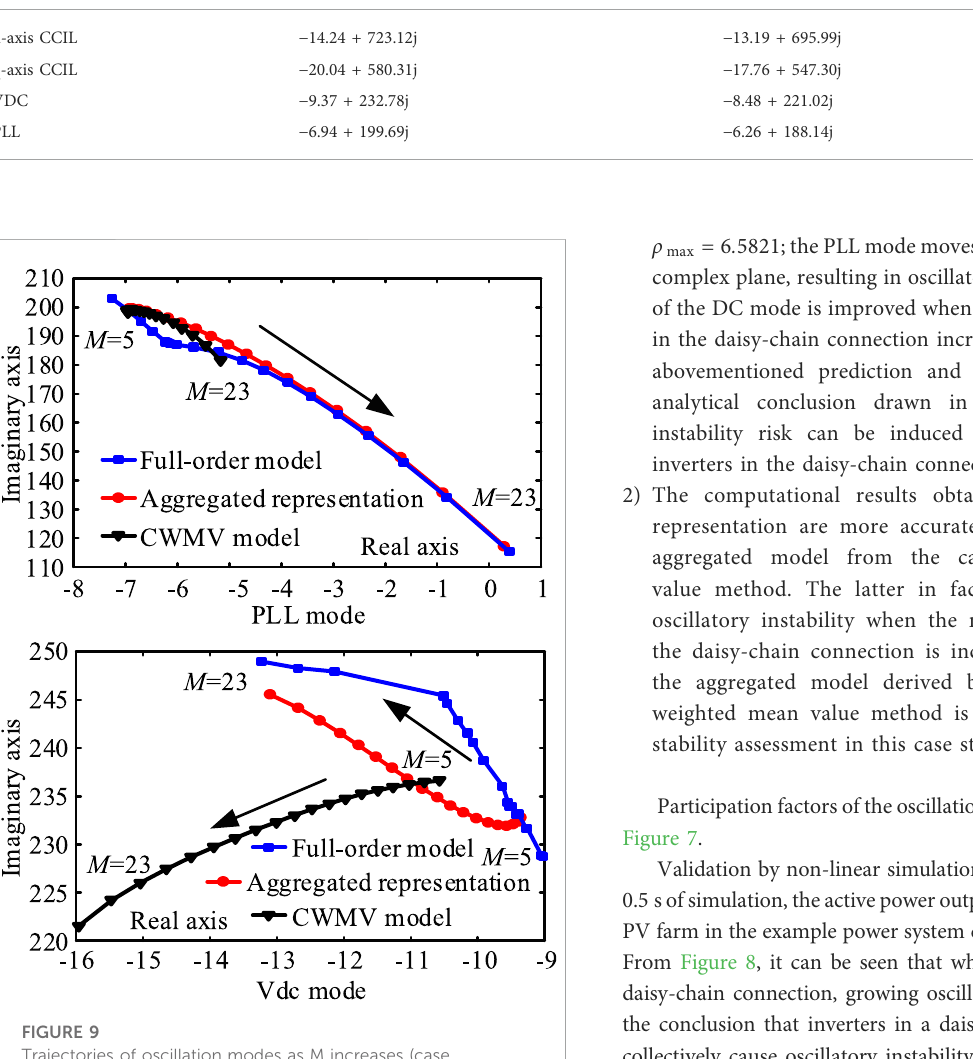
FIGURE 9 Trajectories of oscillation modes as M increases (case study